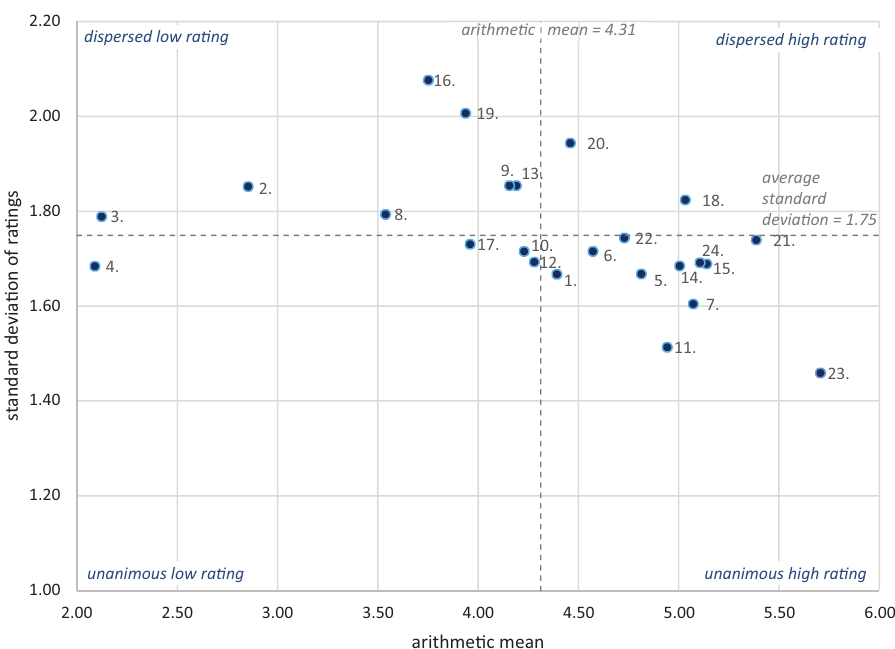
Figure 5. Distribution of 24 statements relating to the completed vocational guidance